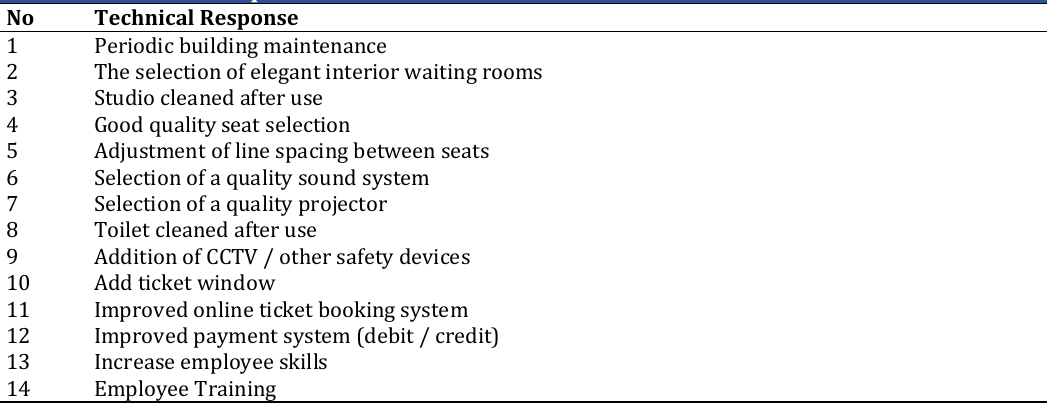
Table 2: Technical